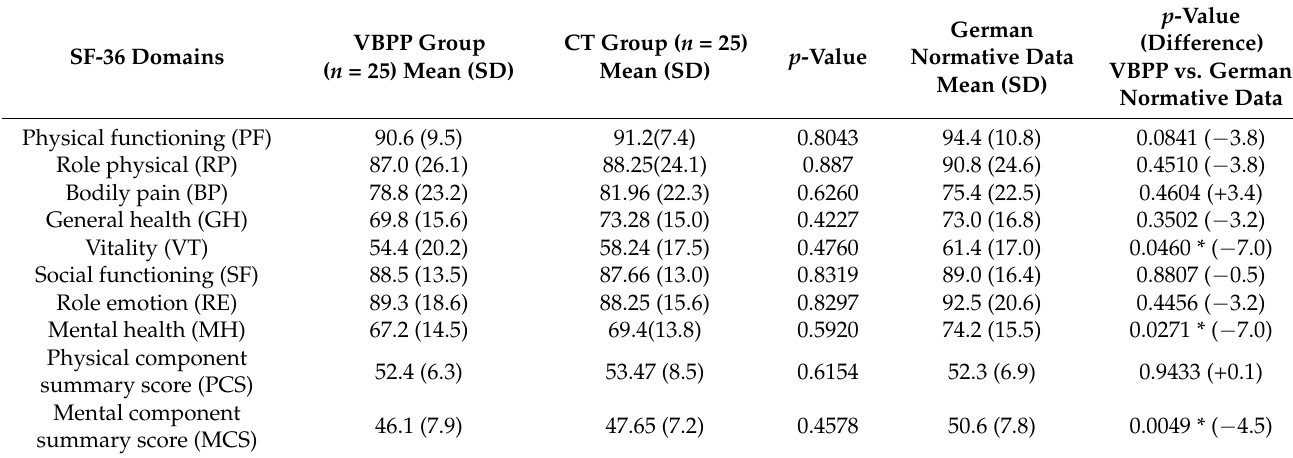
Table 3. SF-36 results of patients who underwent VBPP compared to CT patients and the normative data from the general German